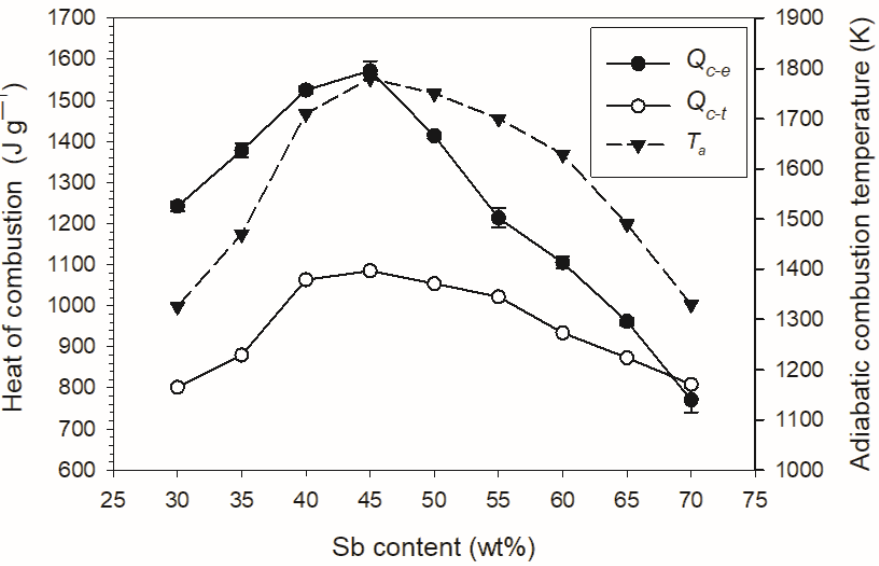
Figure 12. Adiabatic combustion temperature ( T a ), experimental ( Q c-e ) and theoretical ( Q c-t ) heat of combustion depending on the antimony content.